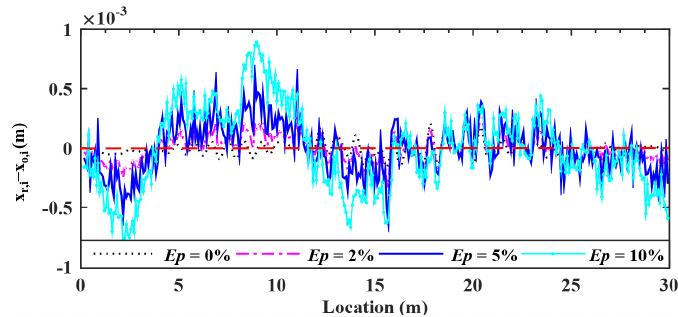
Figure 14. Deviations of surface profiles identified for different noise levels.